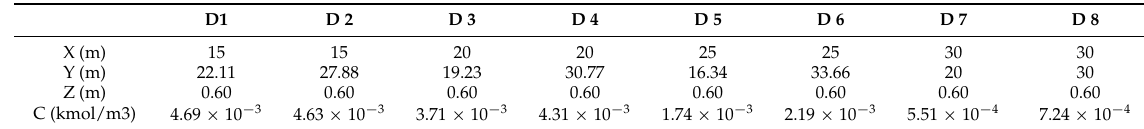
Table 17. The coordinates of the sensors and the corresponding concentration according to the standard sector deployment